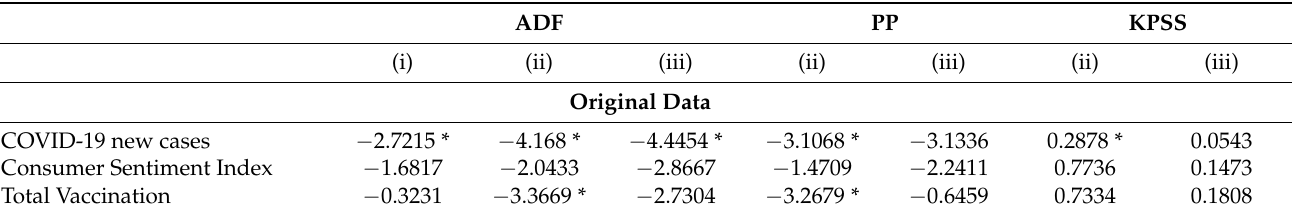
Table 2. Unit root tests.